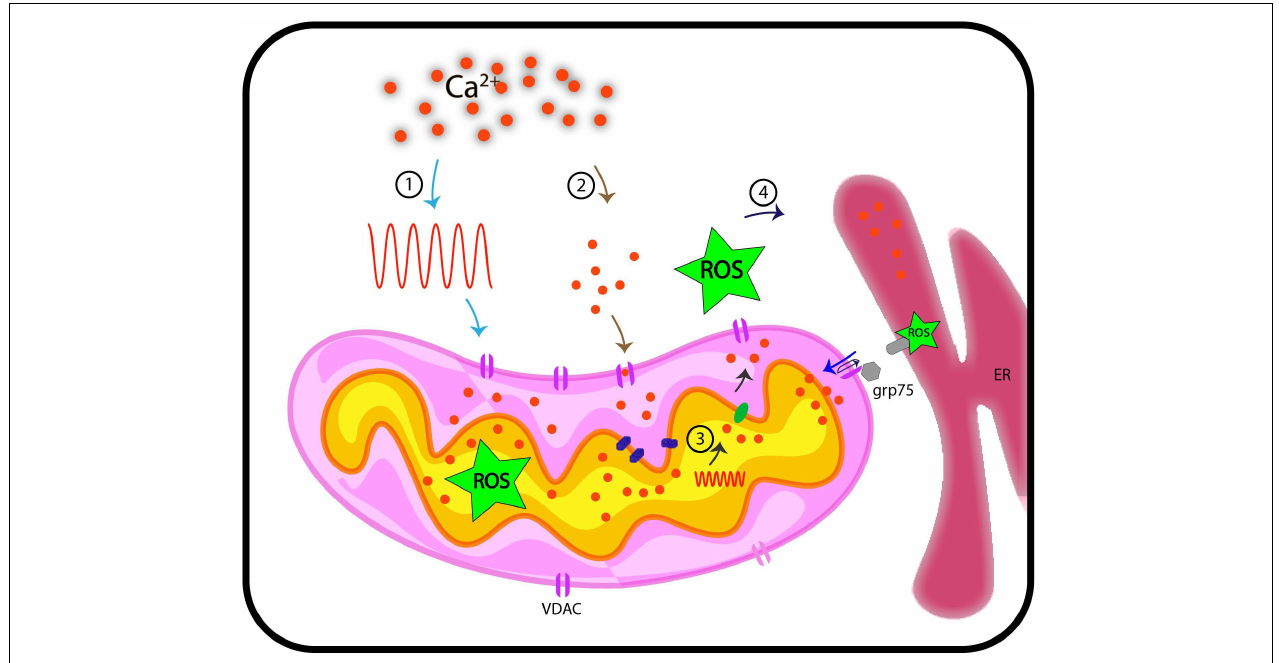
FIGURE 2 | Representation of functional implications of VDACs, Ca 2 + , and ROS in cellular signaling. This hypothetical model traces pathways through which VDAC may regulate Ca 2 + and ROS signaling in plants. We discuss here four possible routes that we currently posit are VDAC mediated connection between Ca 2 + and ROS signaling. (1) When cytosolic Ca 2 + level increases on perception of stimuli (generation of Ca 2 + signature), these signals are transduced downstream, where they influence the activity of VDACs. This might results in increased level of ROS in mitochondria. (2) VDAC serves passively to regulate Ca 2 + levels in mitochondria. (3) Stimuli such as oxidative stress (inclusive of increased ROS level) and touch response results in generation of Ca 2 + signature in mitochondria, independent of cytosolic Ca 2 + signature. (4) VDAC can be a candidate protein that leads to flux of Ca 2 + /ROS from inter-membrane space to cytosol. Further, VDACs are known to connect ER based Ca 2 + signaling and mitochondria through Ca 2 + and ROS molecules and this may depict another possible mechanism of how VDAC connects Ca 2 + and ROS. These hypothetical routes may (or may not) be connected. ER, endoplasmic reticulum; ROS, reactive oxygen species; grp75, glucose related protein 75; Ca 2 + , calcium; VDAC, voltage-dependent anion channel.